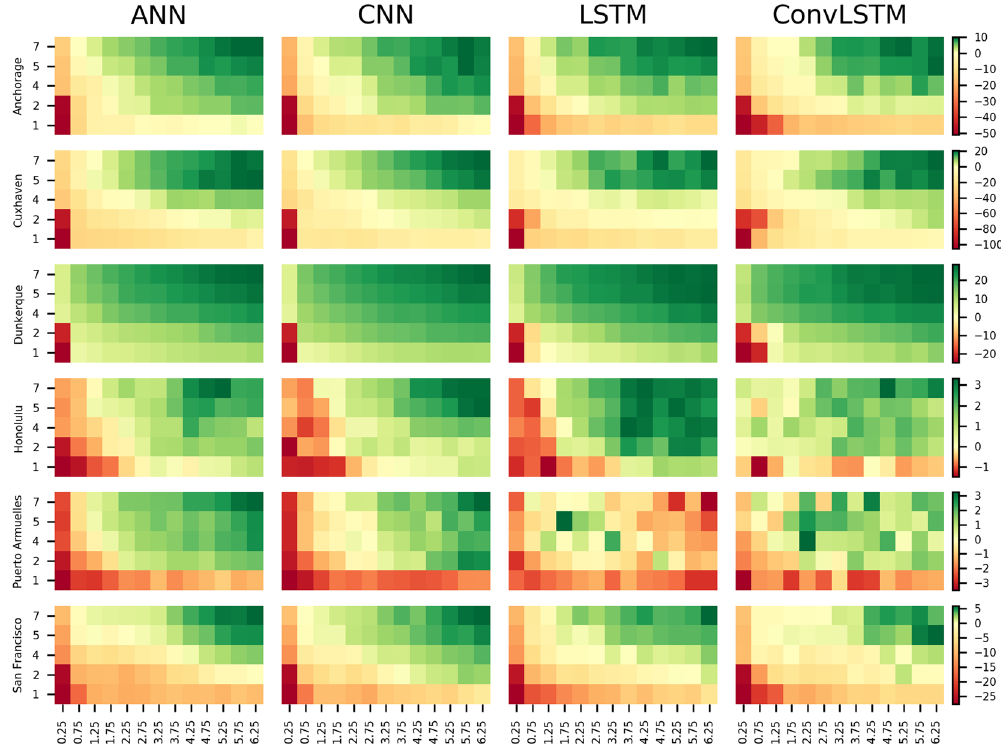
Figure 6. CRPSS value of the NN model ensemble for increasing number of predictor variables and spatial footprint size. On the horizontal axis the spatial footprint is depicted and on the vertical axis the number of predictor variables are depicted with cumulatively 1 (MSLP); 2 (wind magnitude); 4 (U and V); 5 (gradient of MSLP); 7 (quadratic of U and